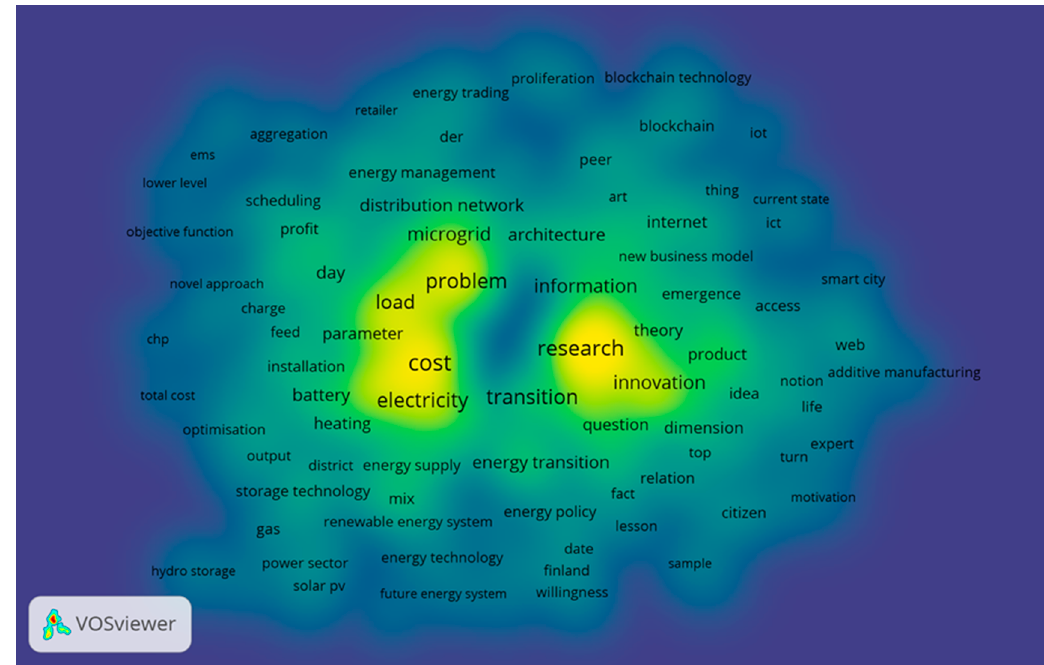
Figure 6. Density plot of full counting analysis of abstracts by VOSviewer.